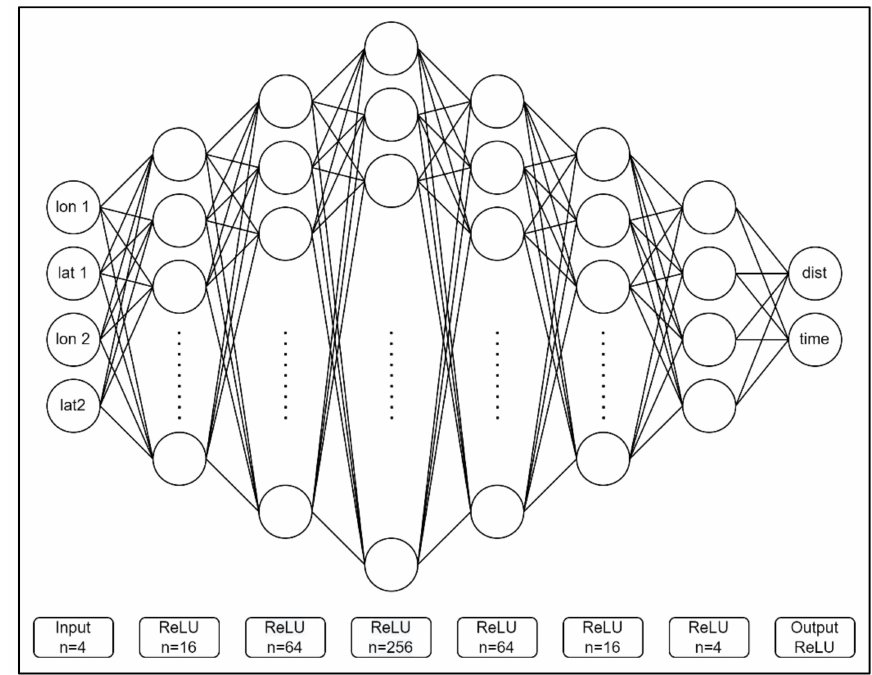
Figure 3. The ANN structure used for